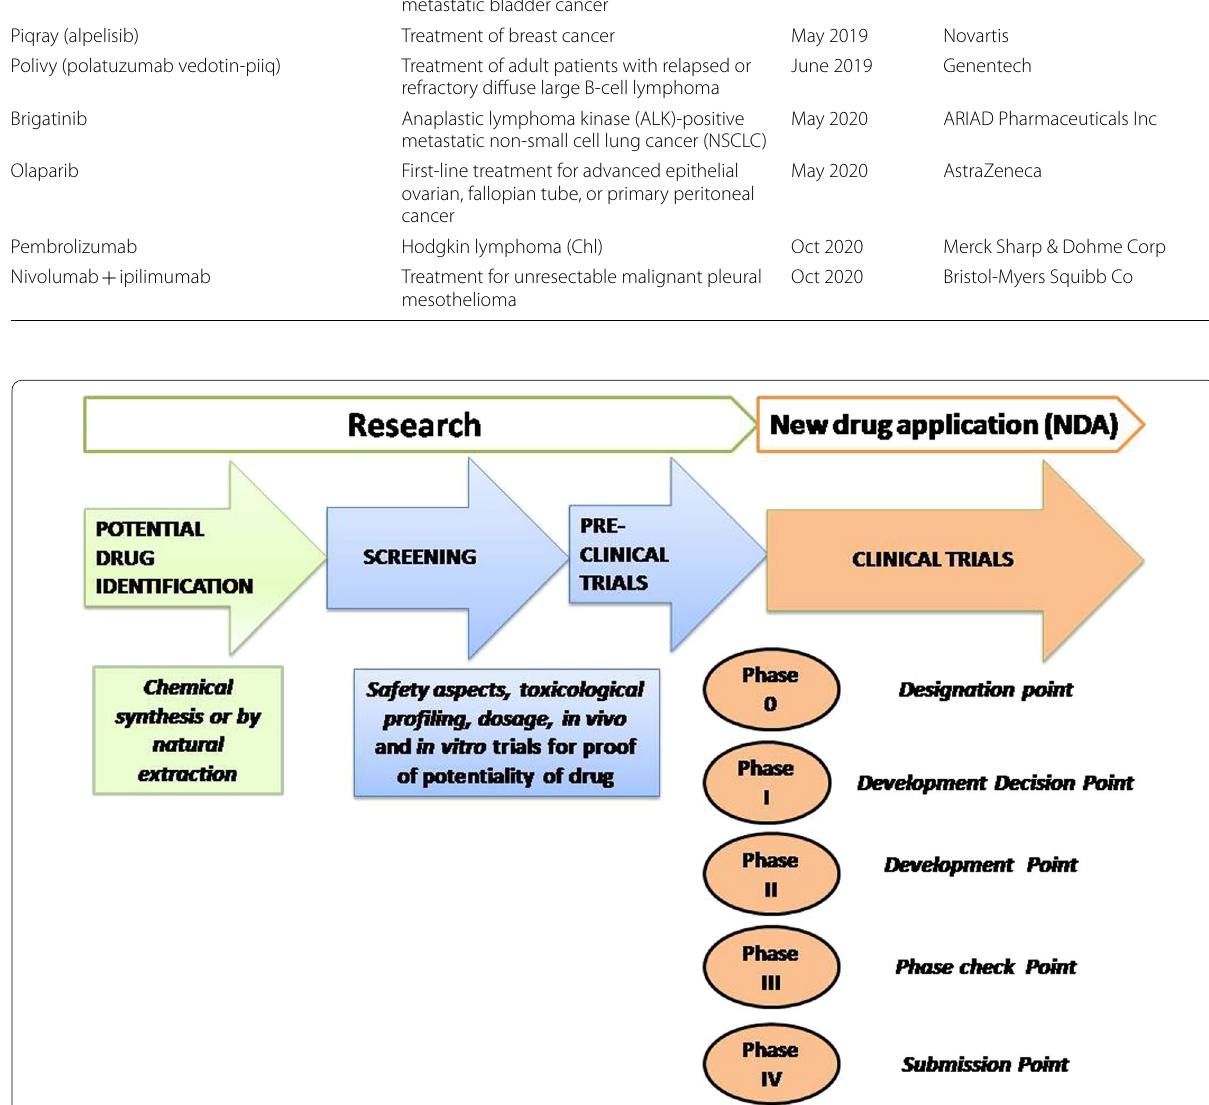
Fig. 2 Stages of anticancer drug